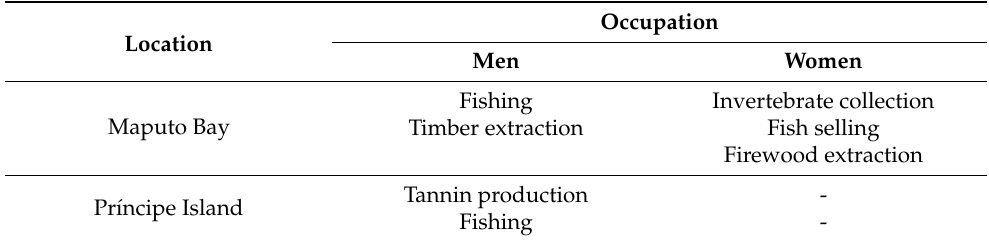
Table 5. Use of mangrove resources by gender in Maputo Bay and Príncipe Island.